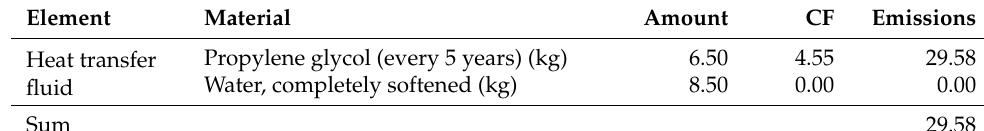
Table 12. Maintenance emissions from ST